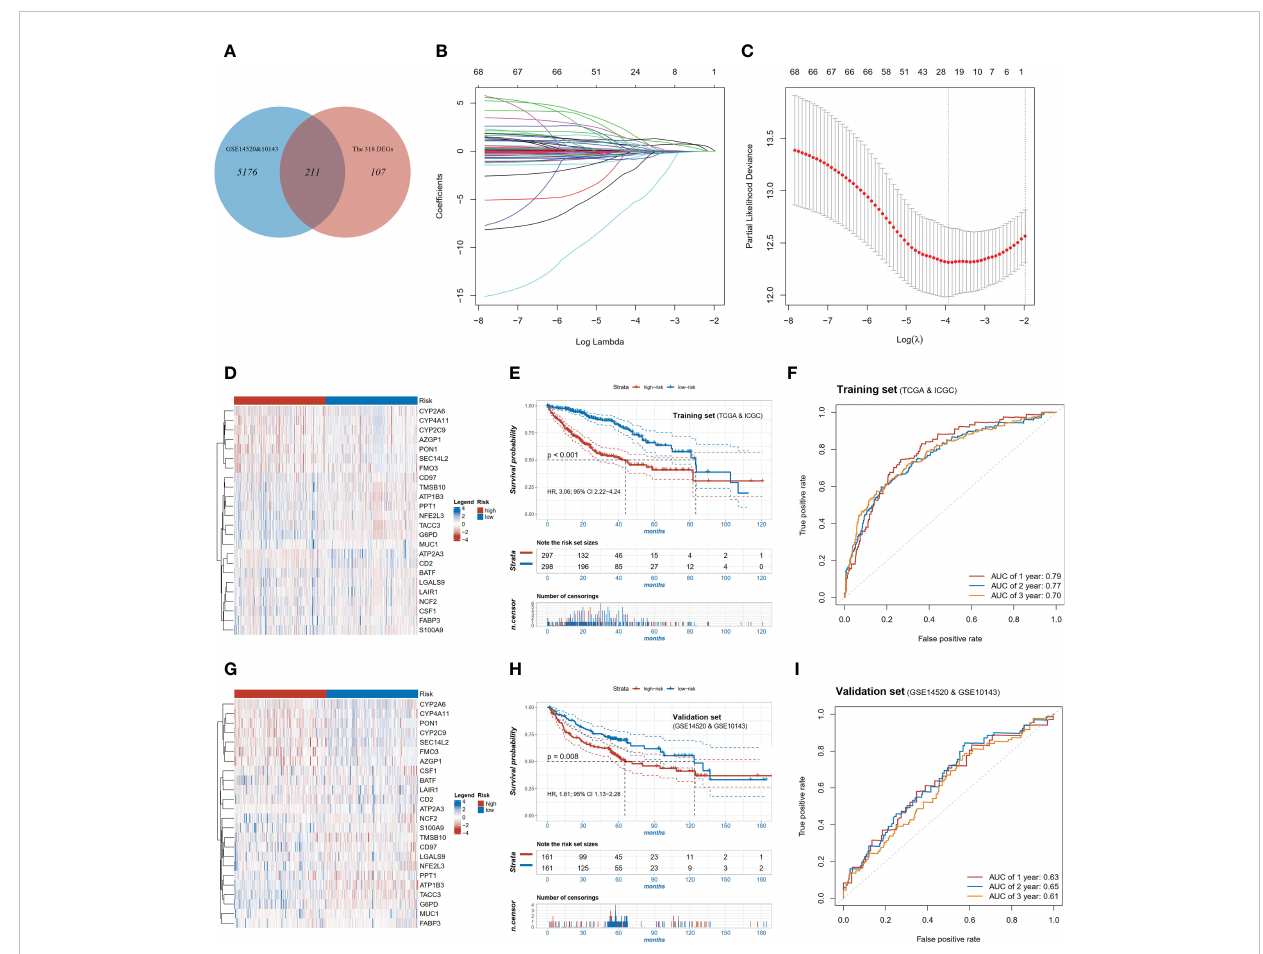
FIGURE 3 Construction and validation of the pyroptosis-related signature. (A) Venn diagram showing overlapping genes of DEGs and the genes detectable in GEO; (B) LASSO coef fi cient pro fi les of the 68 OS-associated genes; (C) Log Lambda value for LASSO regression; (D) Expression distributions of risk model genes between high and low risk patients in training set; (E) Kaplan-Meier survival curves of high and low risk patients in training set; (F) ROC curve of the risk model in training set; (G) Expression distributions of risk model genes between high and low risk patients in validation set; (H) Kaplan-Meier survival curves of high and low risk patients in validation set; (I) ROC curve of the risk model in validation